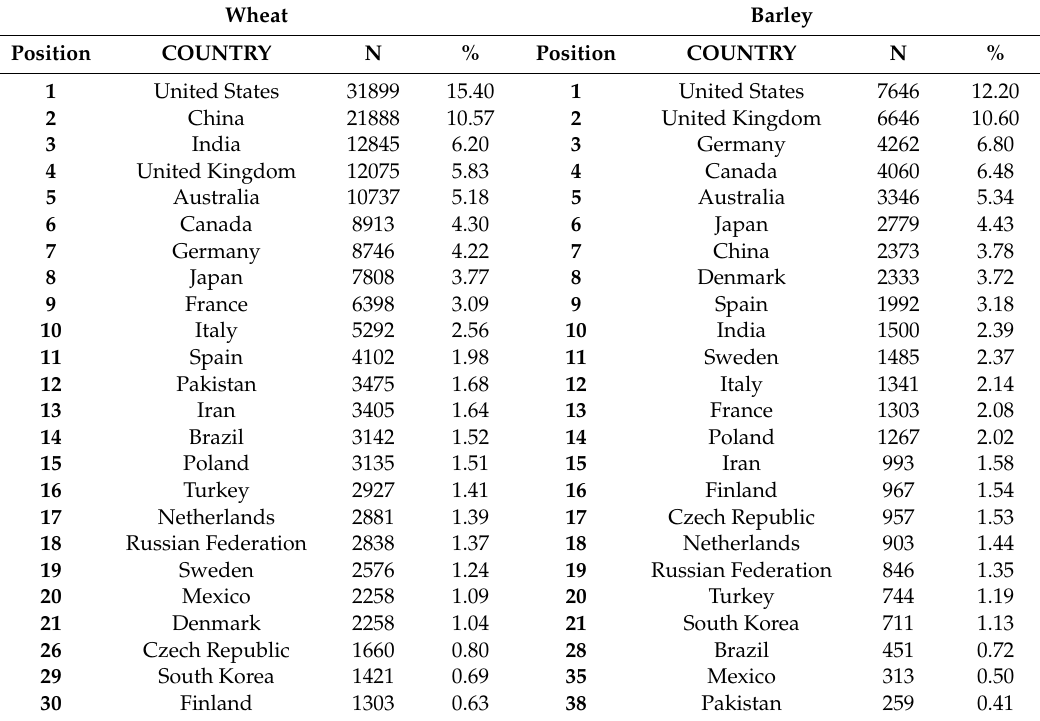
Table 1. Scientific production by countries measured by the absolute number (N) and the relative contribution (%) of documents in the wheat and barley research fields. Their position in a ranking according to number of documents published is also indicated.